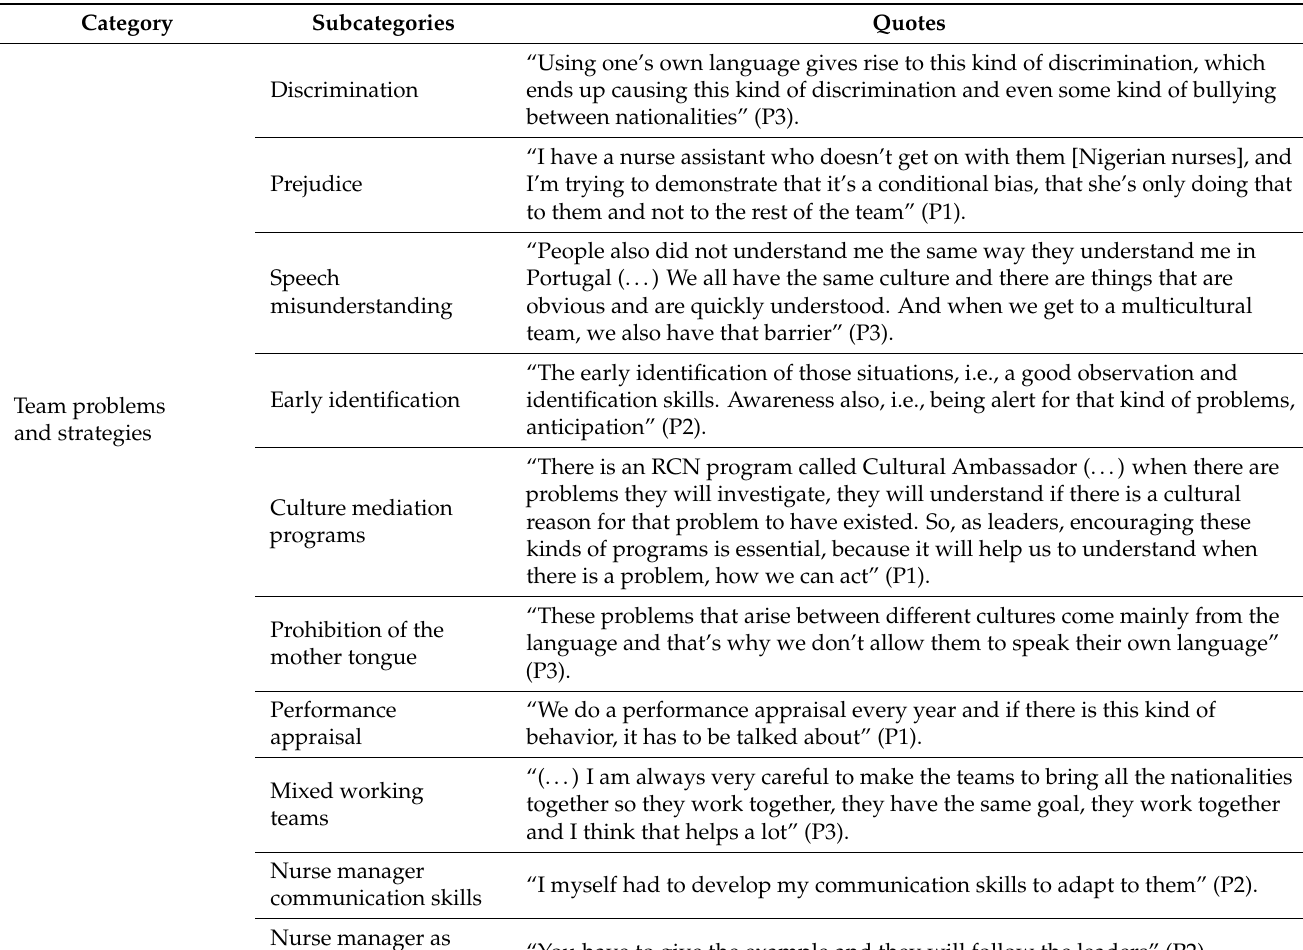
Table 4. Subcategories of the “Team problems and strategies” category and participants’ quotes. Category Subcategories